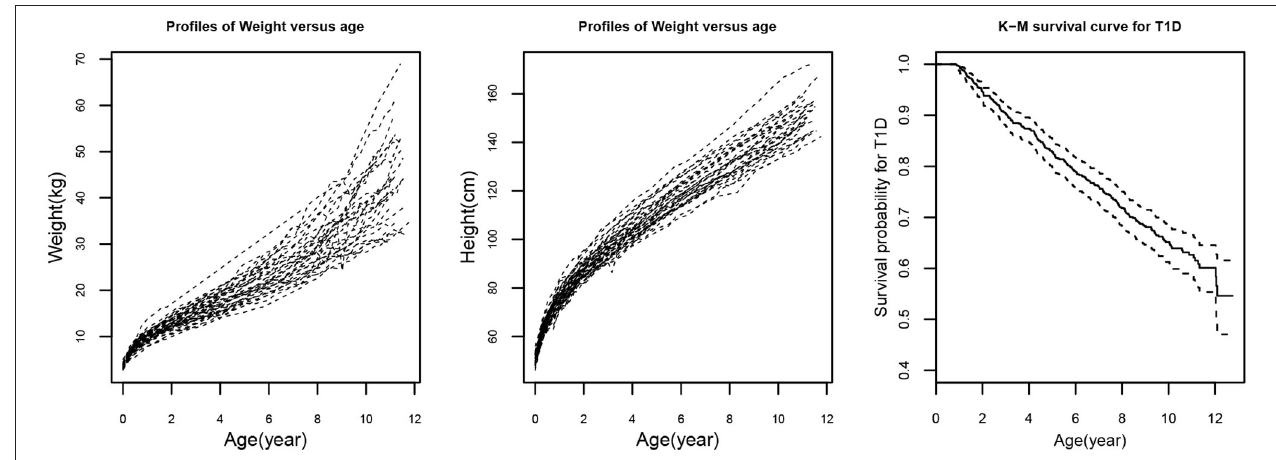
FIGURE 1 | Randomly selected 50 trajectories of weight (left panel) and height (middle panel) from a diabetes study. Kaplan-Meier (K-M) survival plot (right panel) for type 1 diabetes